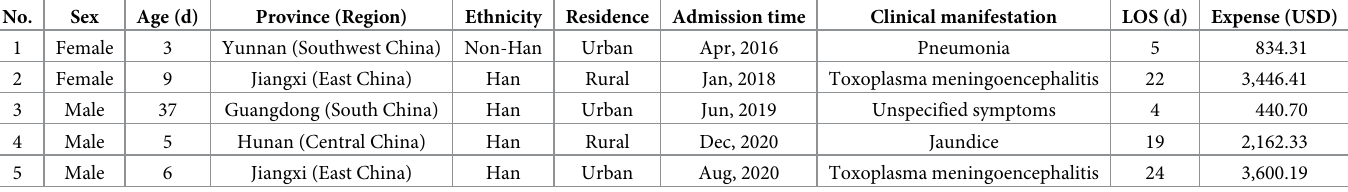
Table 2. The general sociodemographic characteristics and disease burden of pediatric patients with T . gondii infection during hospitalization from December 2015 to December 2020.